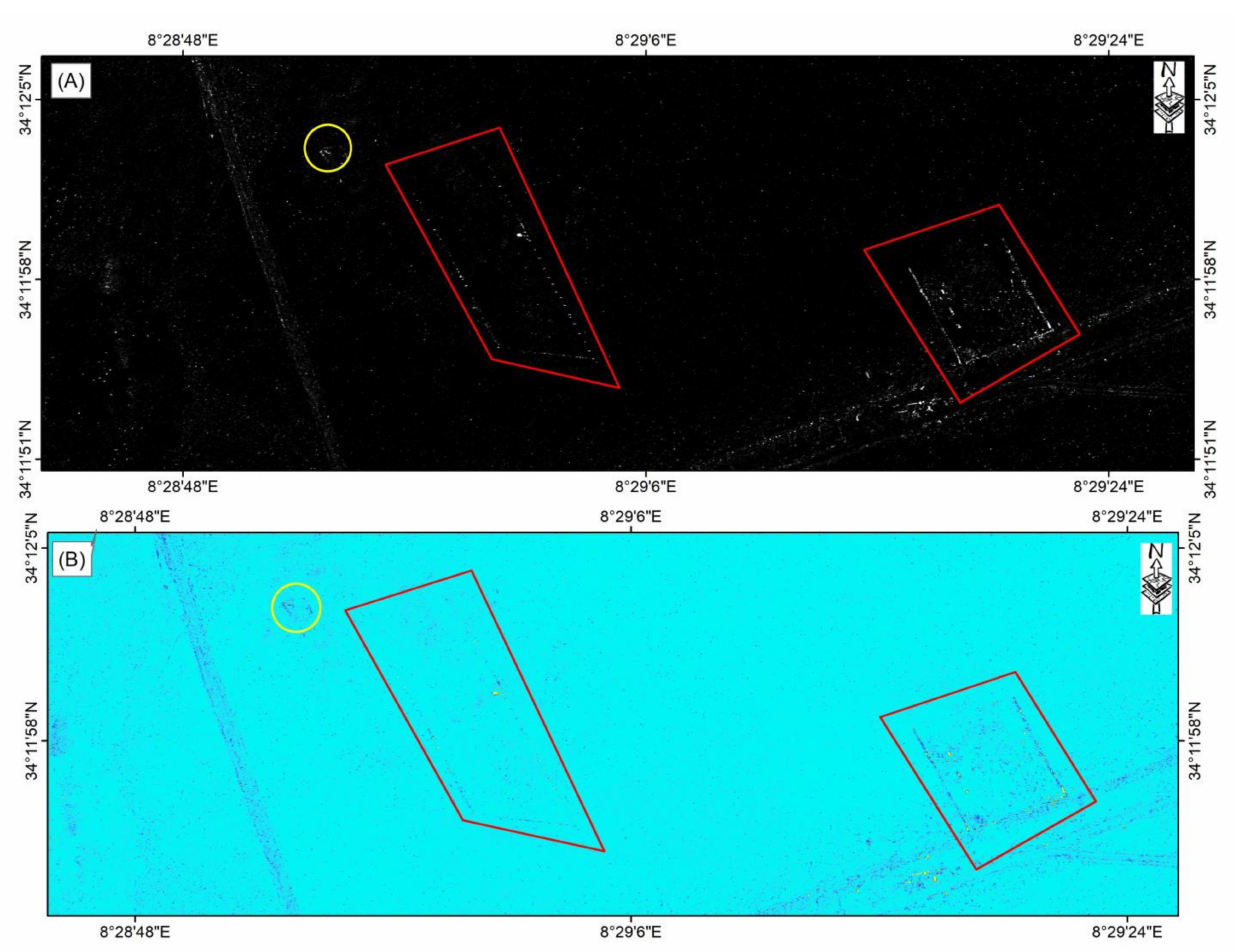
Figure 7. Identification of the archeological features of the deserted fortress (site 1) at Henchir BouG ô ra, Tunisia, from TSK ST data after application of the NL-SAR method. ( A ) High-resolution TSX ST-mode image of site 1 acquired on 27 February 2021 with a spatial resolution of 0.22 m under HH polarization at an incidence angle of 38.6 ◦ (© DLR, 2021); ( B ) NL-SAR intensity result. The red polygons and yellow circle enclose features of the ancient fortress in the eastern part of the study